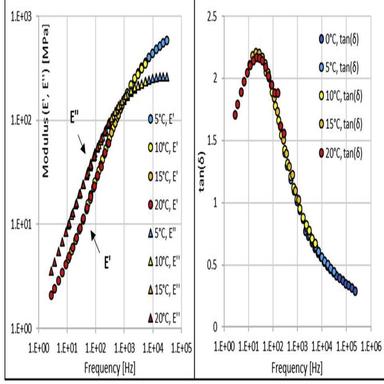
DMA TTS frequency-domain storage (E') and loss (E'') moduli (left) and loss tangent (right) master curves for A30 shifted using Williams-Landel-Ferry shift constants C1 = 10.5, C2 = 100.